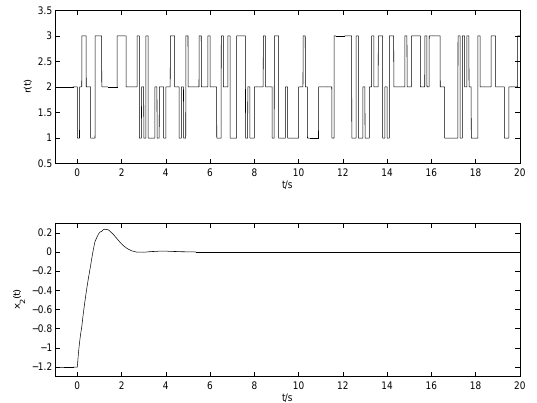
Figure 2: Time response of the state variable x 2 ( t ) of the MJNNS.